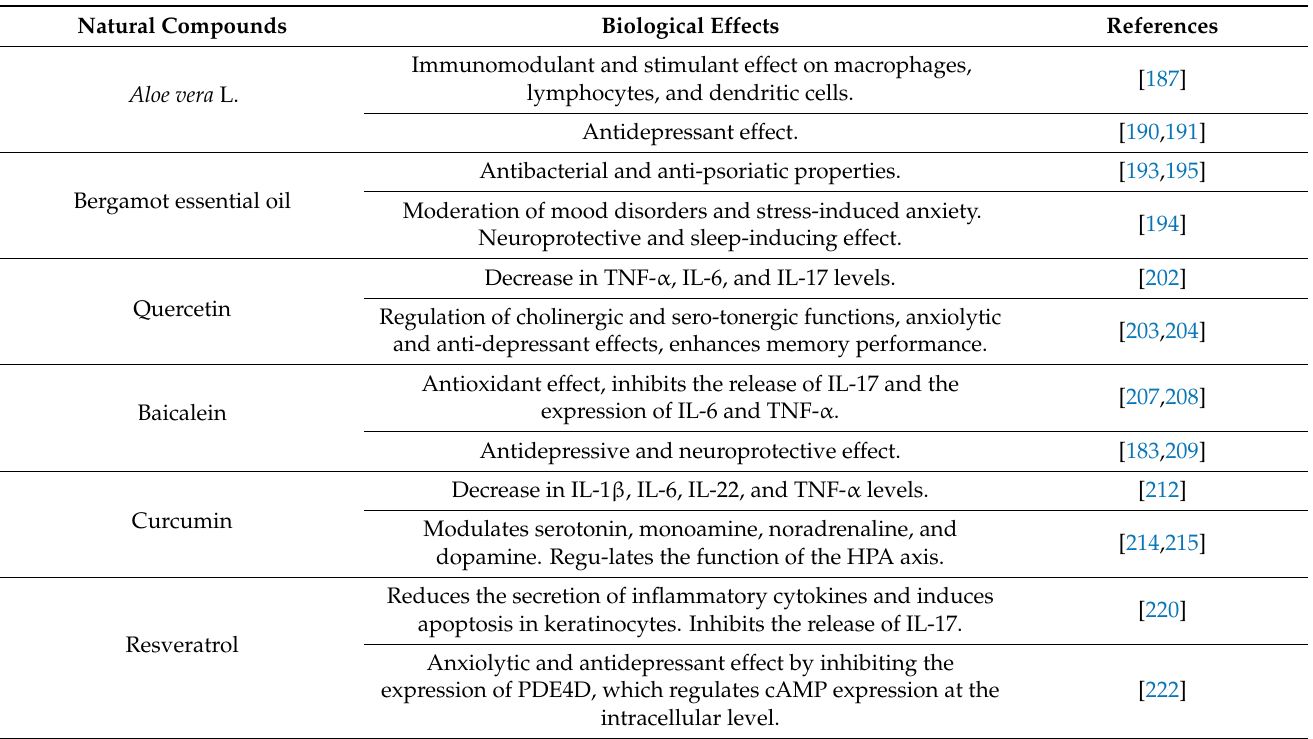
Table 1. Biological effects of natural compounds on